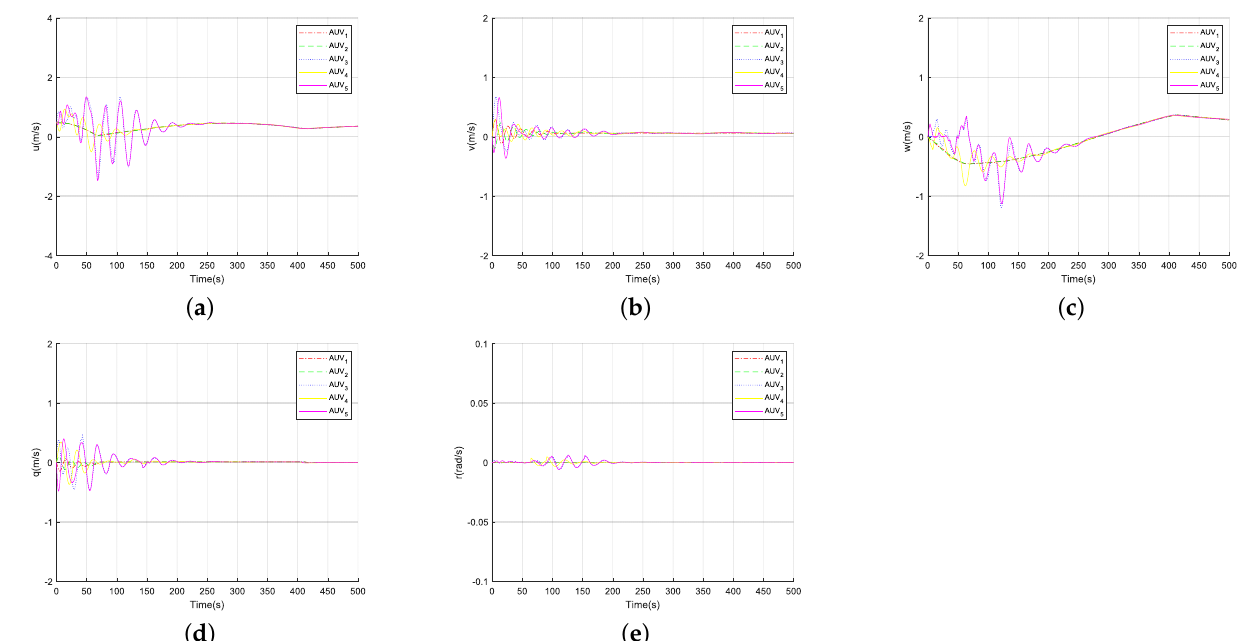
Figure 5. The other states of the multi − AUV formation: ( a ) the u state of multi − AUV, ( b ) the v state of multi − AUV, ( c ) the w state of multi − AUV, ( d ) the q state of multi − AUV, ( e ) the r state of multi − AUV.